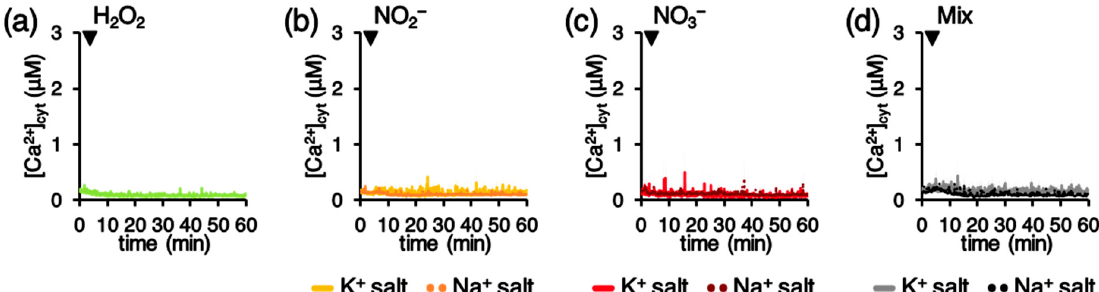
Figure 7. Monitoring of [Ca 2+ ] cyt in response to hydrogen peroxide, nitrite, and nitrate at the same doses as those measured in the PAW at 1:2 dilution. Ca 2+ measurement assays were conducted in aequorin-expressing Arabidopsis seedlings. At 100 s (arrowheads) seedlings were challenged separately with: ( a ) 8.7 µ M H 2 O 2 (green trace); ( b ) 520.1 µ M NO 2 − (provided as K + salt, yellow trace; provided as Na + salt, orange trace); ( c ) 264.2 µ M NO 3 − (provided as K + salt, red trace; provided as Na + salt, brown trace); and ( d ) a solution (mix) containing all the above chemicals (with NO 2 − and NO 3 − provided as K + salt, grey trace; with NO 2 − _and NO 3 − provided as Na + salt, black trace). Data are the means (solid lines) ± SE (shading) of six different seedlings derived from three independent growth replicates.